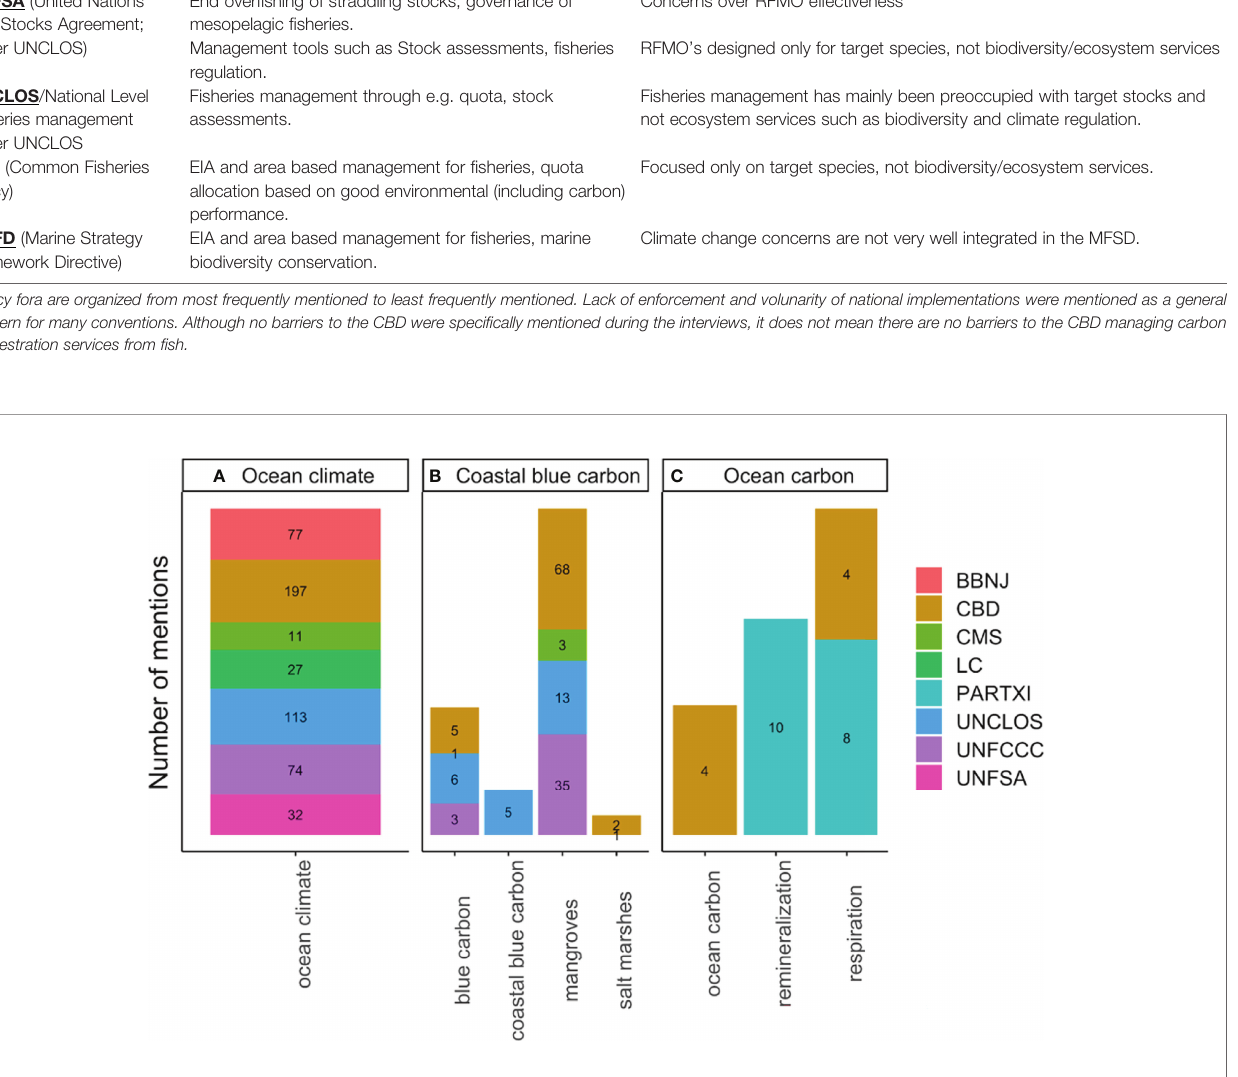
FIGURE 2 | Number of mentions per keyword in studied policy documents; BBNJ (Biodiversity of Areas Beyond National Jurisdiction); CBD (Convention on Biological Diversity); CMS (Convention on the Conservation of Migratory Species of Wild Animals); ICRW (International Convention for the Regulation of Whaling); LC (London Convention); UNCLOS (United Nations Convention of the Law of the Sea); Part XI (Part XI of UNCLOS); UNFCCC (United Nations Framework Convention on Climate Change); UNFSA (United Nations Fish Stocks Agreement). For keywords referring to (A) ocean and climate in the same sentence (B) coastal blue carbon (C) open ocean carbon. Note that the y-axis is log-transformed to ease